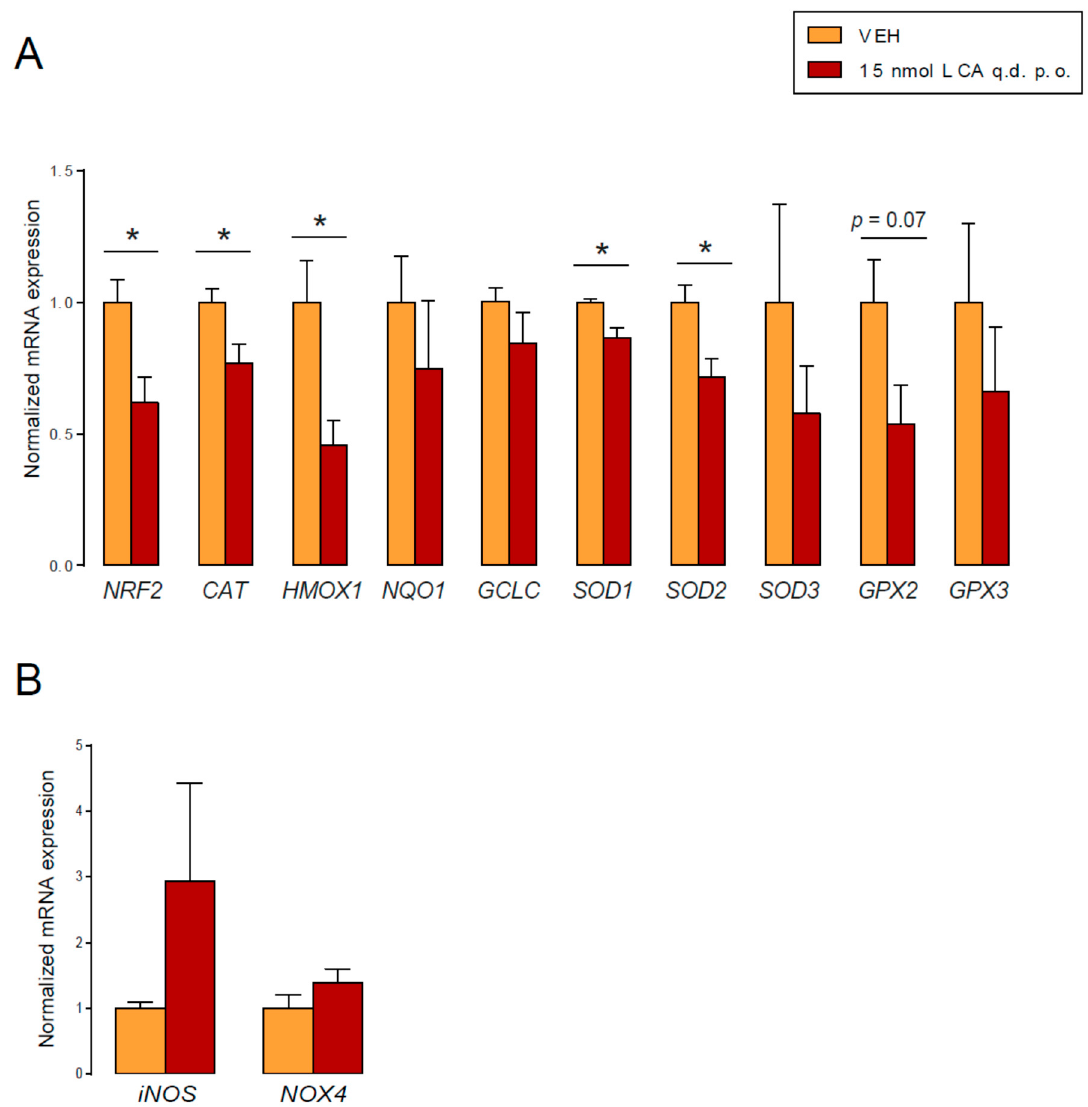
Figure 10. LCA modulated the expression level of antioxidant and pro-oxidant genes in vivo . ( A , B ) Female Balb/c mice were grafted with 4T1 cells and treated with LCA (15 nmol q.d. p.o.) or vehicle (VEH) ( n = 5/5) for 18 days. The mRNA expression levels of the indicated genes were determined in tumors using RT-qPCR. Error is depicted as SEM. * indicates statistically significant differences between vehicle and treated groups at p < 0.05. (CAT, catalase; GCLC, glutamate–cysteine ligase catalytic subunit; GPX2, glutathione peroxidase 2; GPX3, glutathione peroxidase 3; HMOX1, heme oxygenase 1; iNOS, inducible NO synthase; NOX4, NADPH oxidase 4; NQO1, NAD(P)H quinone